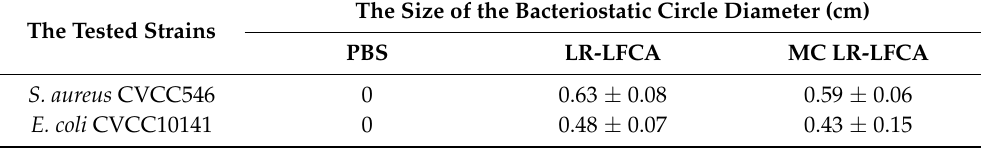
Table 8. Antibiotic activity of the LR-LFCA against pathogenic bacteria. The Size of the Bacteriostatic Circle Diameter The Tested Strains